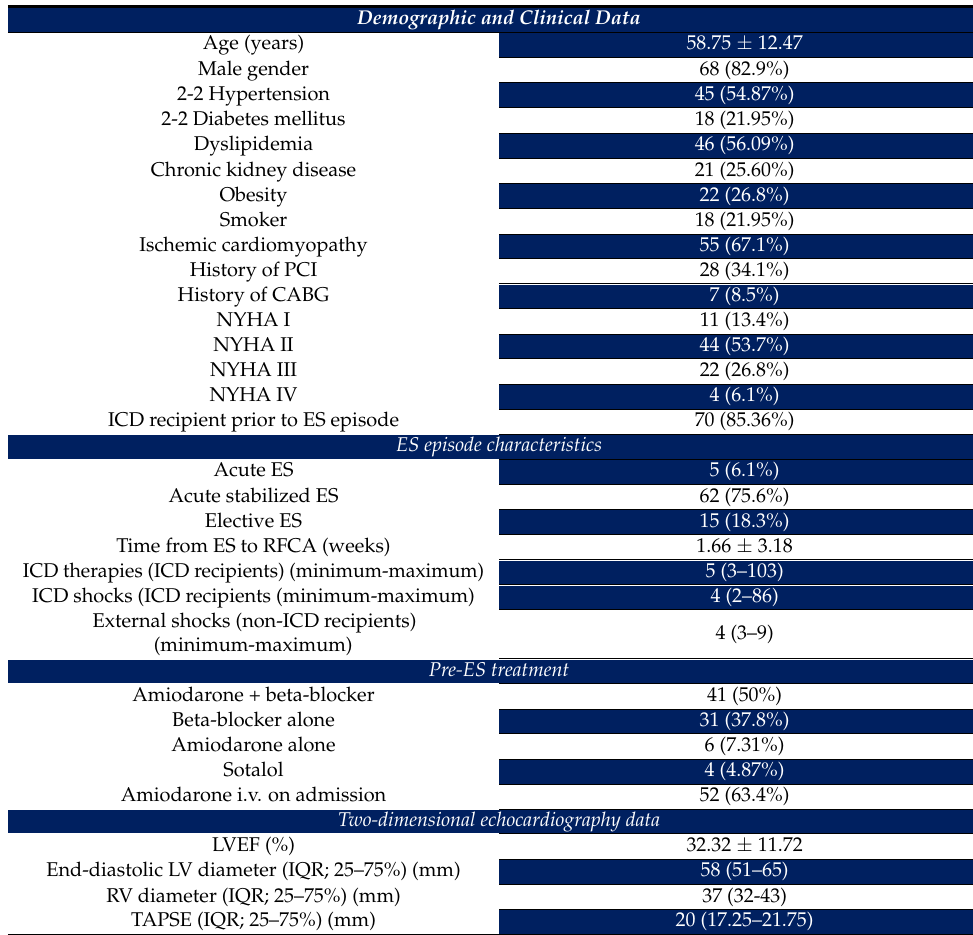
Table 1. Characteristics summary of ES patients referred for RFCA. PCI = percutaneous coronary intervention, CABG = coronary artery bypass graft surgery, ES = electrical storm, ICD = inter- nal cardioverter defibrillator, LVEF = left ventricular ejection fraction, RFCA = radiofrequency catheter